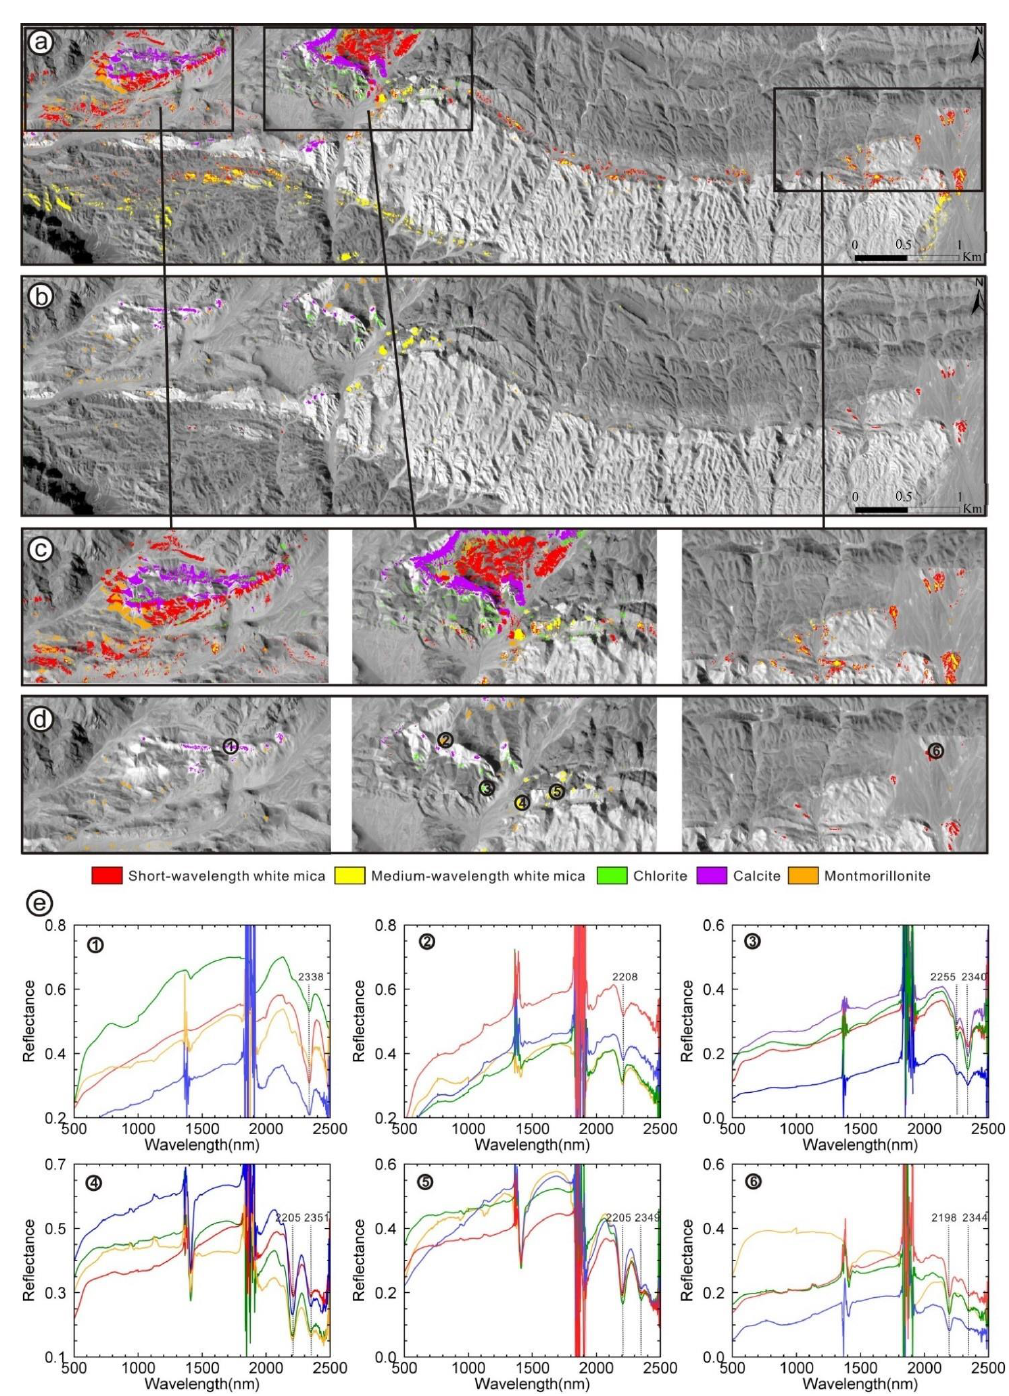
Figure 4. Sample distribution map of the test area. ( a ) MTMF mapping results of SASI images in the test area, ( b ) The distribution of samples in the image, ( c ) The MTMF mapping results in three sample selection areas, ( d ) Distribution of samples in three corresponding areas and location of ground truth data points numbered 1 (cid:13) – 6 (cid:13) , and ( e ) Spectral measurement results for corresponding ground points, where the spectral curves of different colors represent the measurement results of different outcrops at the point, obtained by the FieldSpec4 ASD